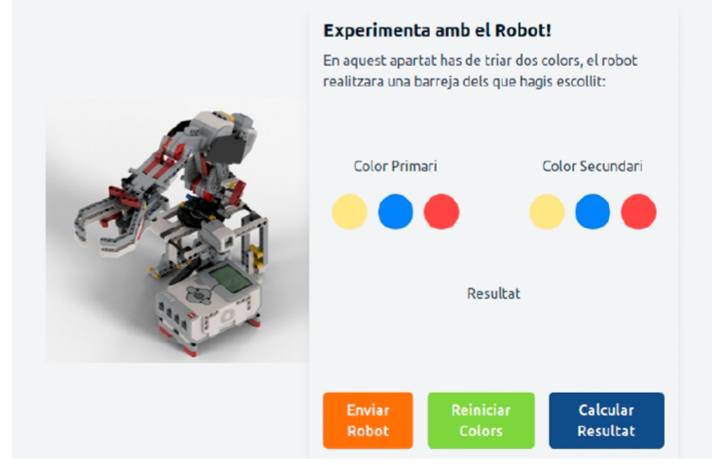
Figure 11. MultiArm Qui-Bot interface for controlling and programming the robot